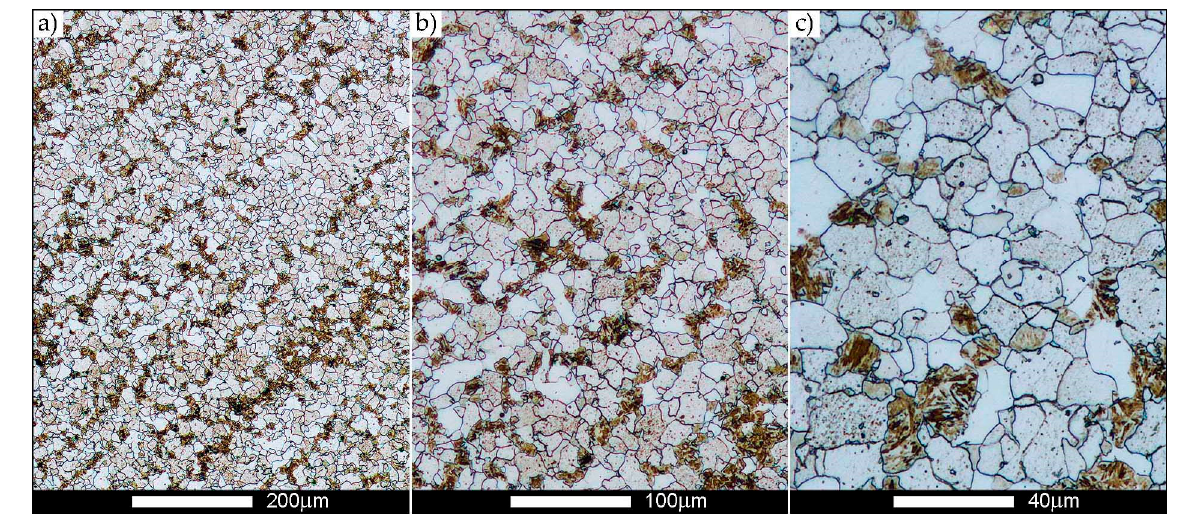
Figure 39. Welded joint microstructure of Hardox 450 steel with visible prior austenite grain boundaries, austenitised at 1000 °C—WM2 zone shown in Figure 2. ( a ) 100×; ( b ) 200×; ( c ) 500×.